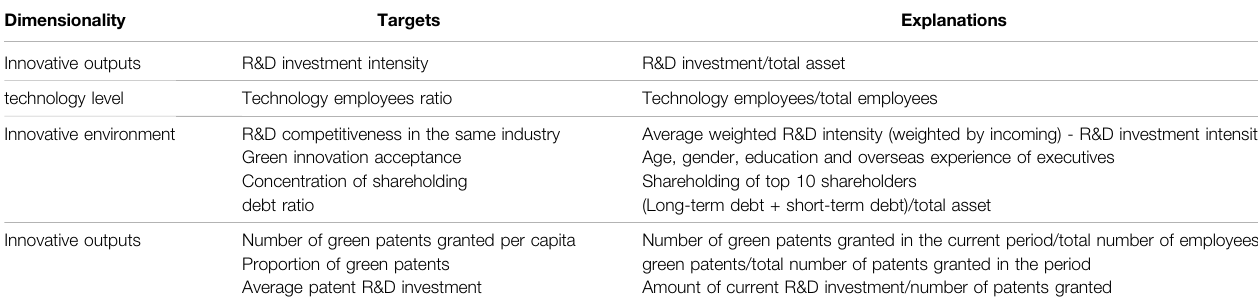
TABLE 1 | Evaluation of the sustainability of green innovation performance.